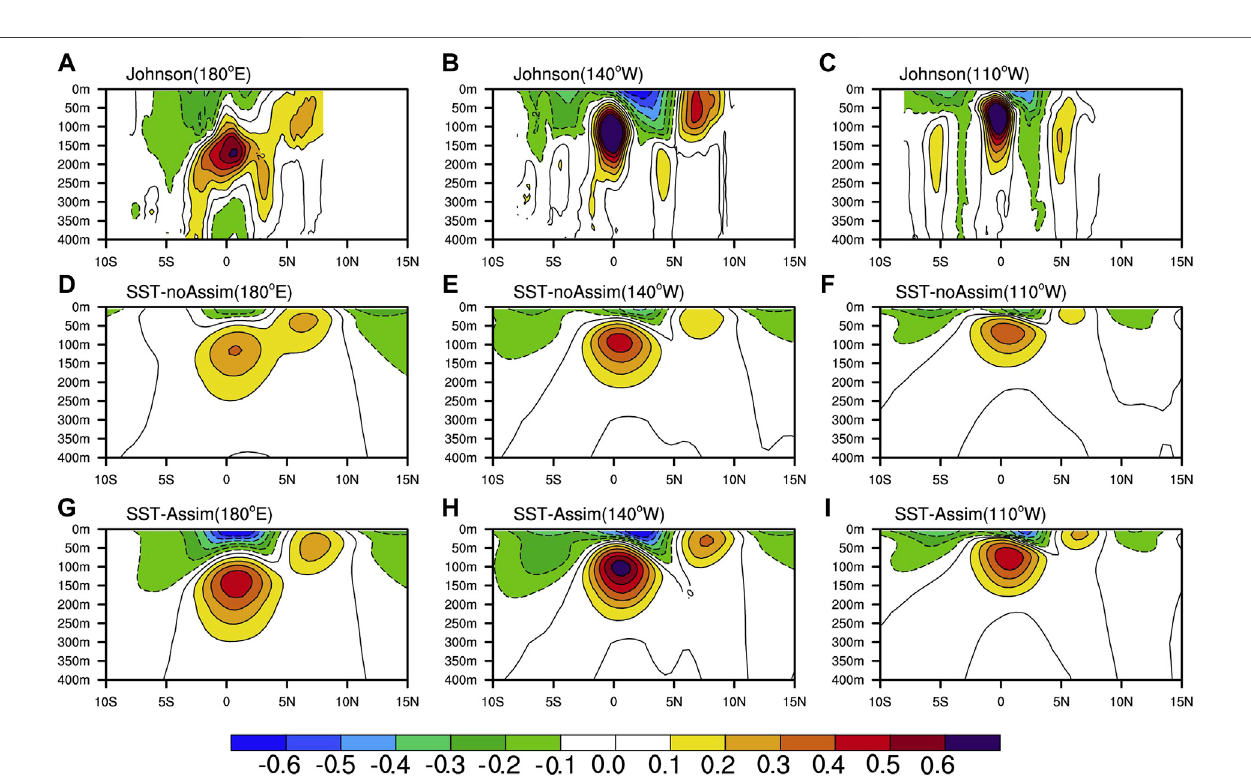
Frontiers in Earth Science |